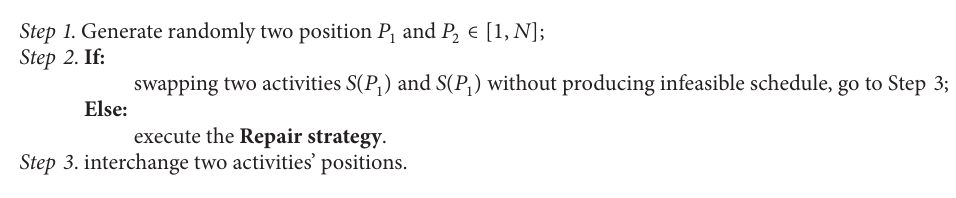
Algorithm 4: Procedure of interchange